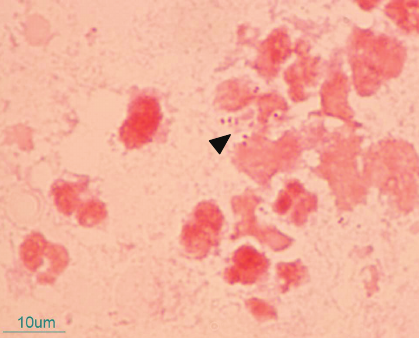
Figure 1: Gram stain of pus specimens obtained from aspiration and incisional drainage of right knee joint showed moderate amounts of gram-negative kidney-shaped diplococci